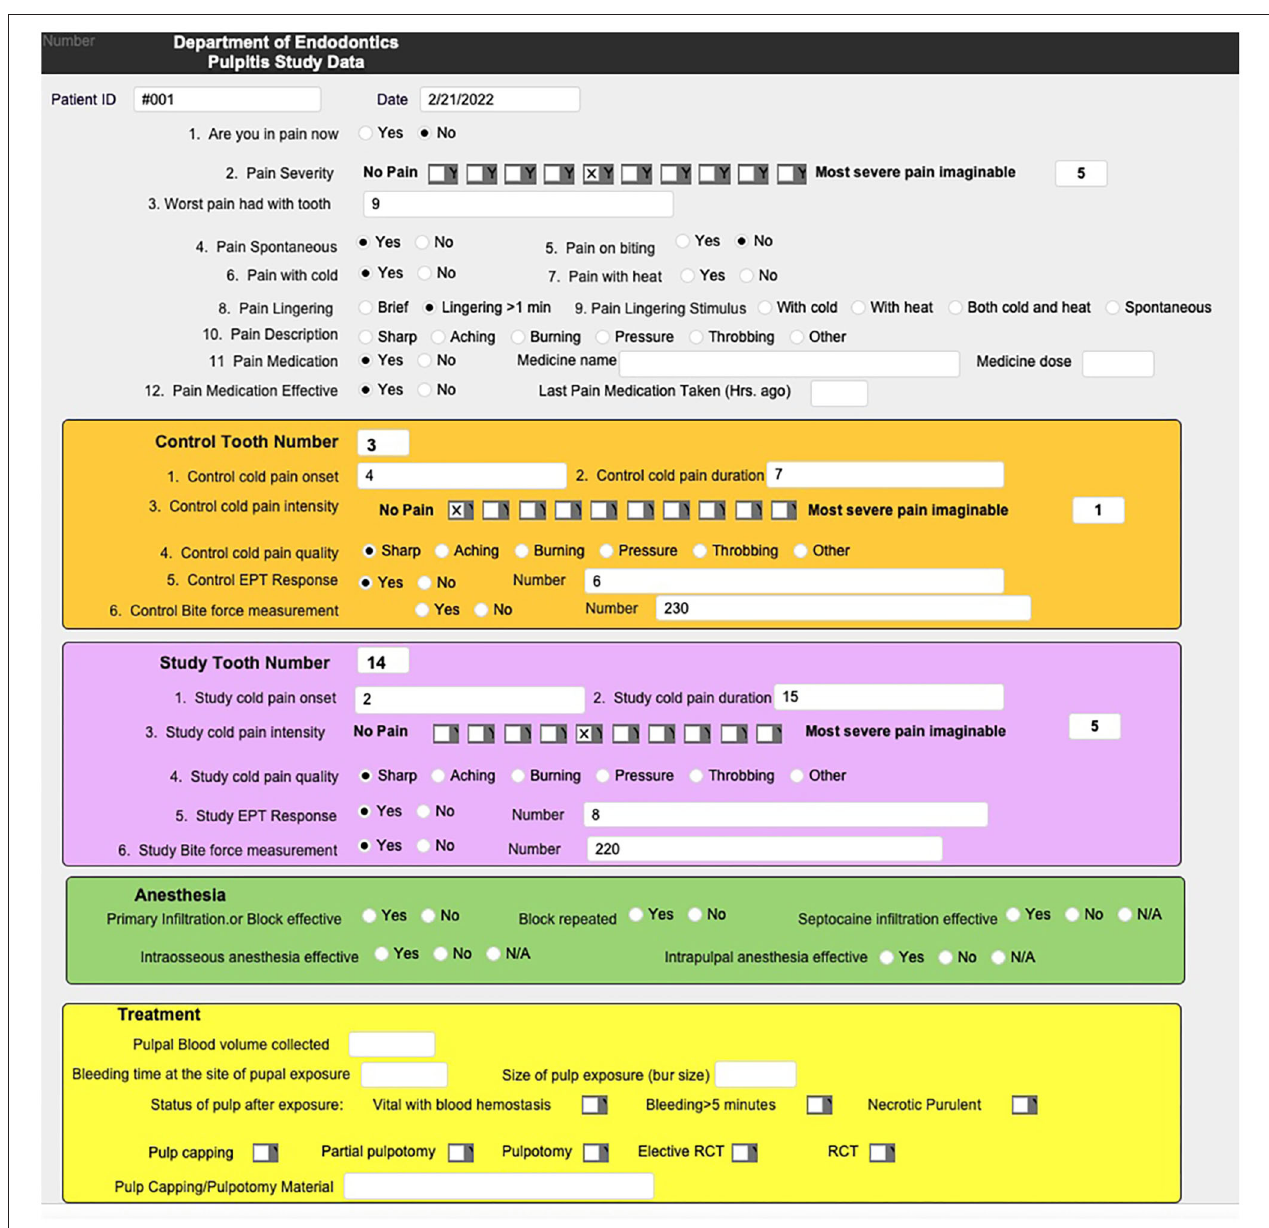
FIGURE 2 | Online database questionnaire was developed using a Filemaker Pro database and used for the collection of systematic clinical signs and symptoms for each patient enrolled in the study.